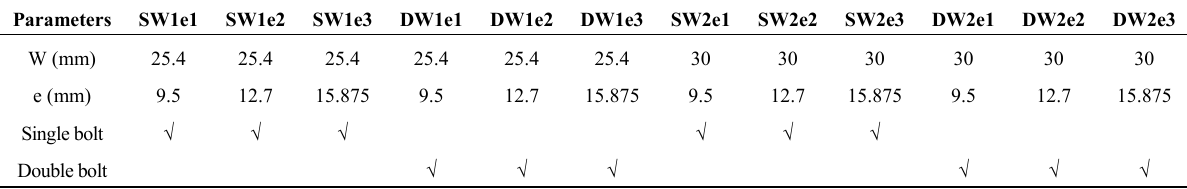
Table 1. Bolted joint specimens coding systems used in this